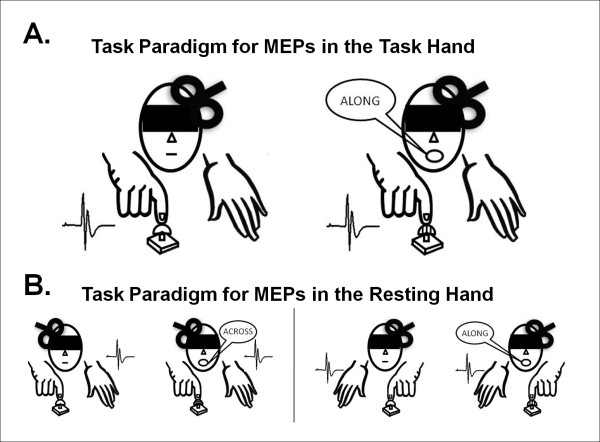
Task paradigm used to assess corticospinal excitability. A. Experiment I. In both grating and smooth trials, participants were trained to produce a single gentle downwards right index finger movement in sync with the sound of a tone lasting for 1.8 s. During the smooth trials, the finger moved downwards to touch a relatively smooth grating dome (0.5 mm spatial period) with no discrimination requirement. During the grating trials, participants touched a coarse grating dome (1.5 or 3 mm spatial period) and reported whether the grooves ran along or across the fingertip. In each trial, the TMS pulse was set to trigger over the left motor cortex 1.5 s after the tone, corresponding to the time point in the trial when the finger was touching the dome and the participant was actively discriminating during the grating trials. Contralateral MEPs were recorded in the task hand. B. Experiment II. The task conditions were identical to Experiment I except that both the right and left hands were tested in Experiment II, and contralateral MEPs were always recorded in the resting hand instead of the task hand.